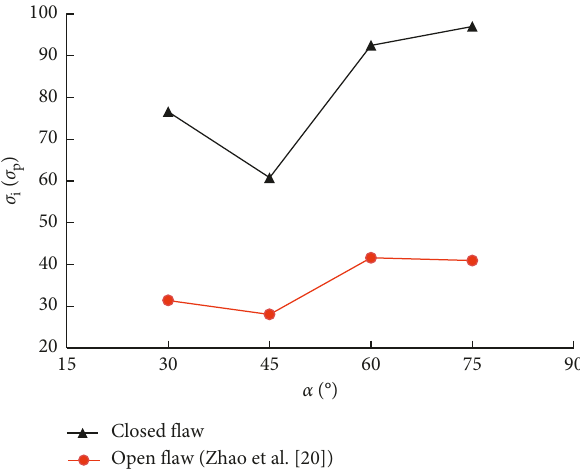
Figure 6: Influence of the flaw inclination angle on the ratio of σ